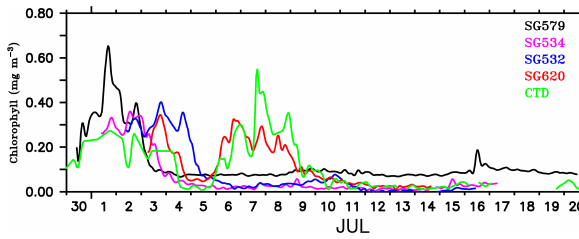
Figure 5. Surface chlorophyll concentration (mgm − 3 ) from ocean gliders (at 1m) and the shipboard CTD (at 3m). SG579 (black) falls within the region of SLD, SG534 (magenta) and SG532 (blue) along the path of SMC and SG620 (red) at the outer edge of SMC, as shown in Fig. 1. CTD (green) observations were collected along the 8 ◦ N section, as described in Fig.